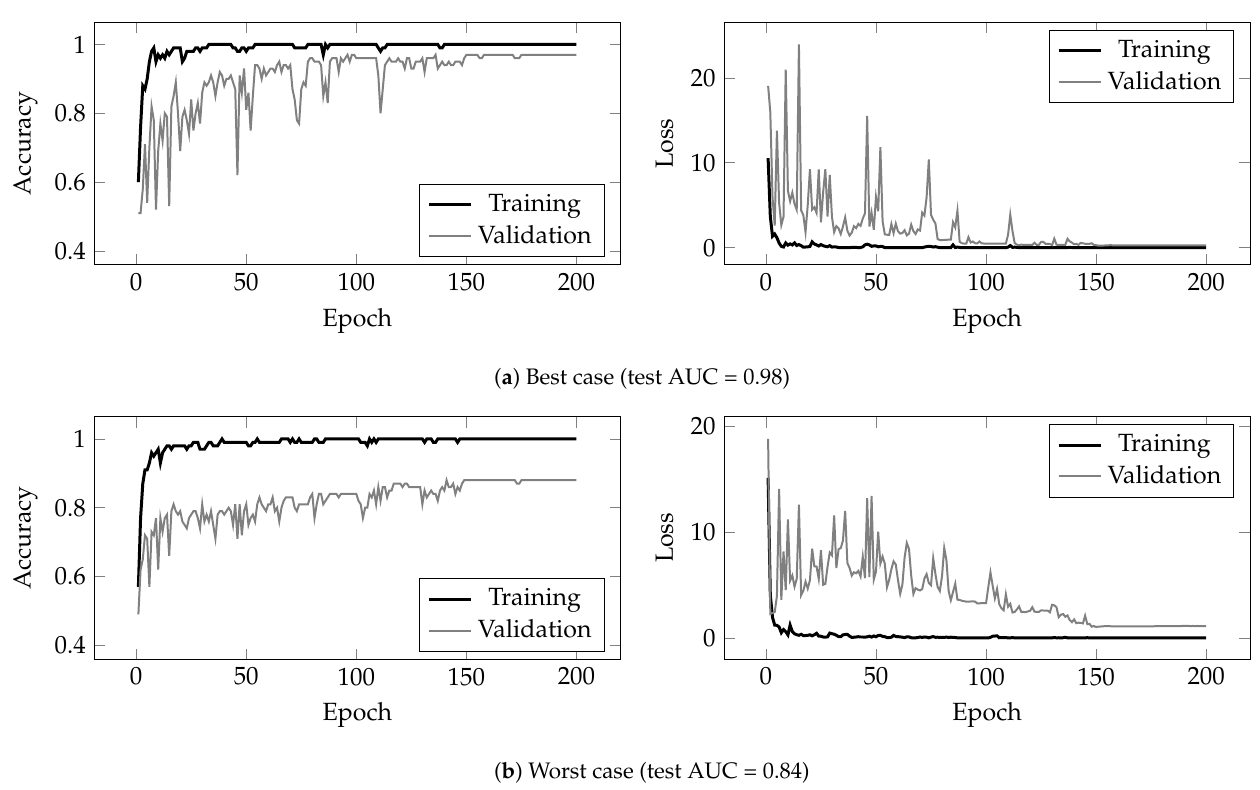
Figure 9. Training graphs for the best ( a ) and worst ( b ) repetitions of the CV